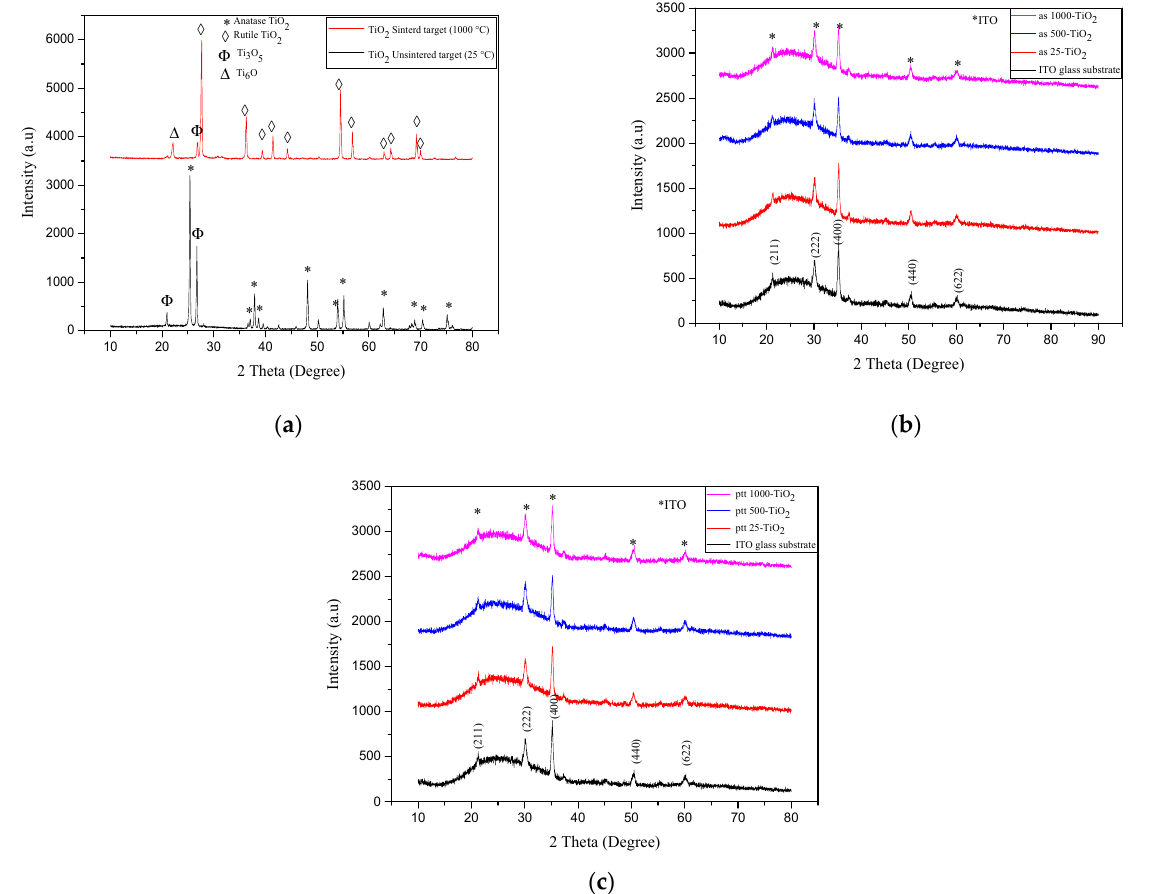
Figure 3. XRD patterns: ( a ) unsintered and 1000 °C sintered target, and PLD TiO 2 thin films on ITO glass substrates; ( b ) before and ( c ) after thermal treatment at 150 °C for 30 min.